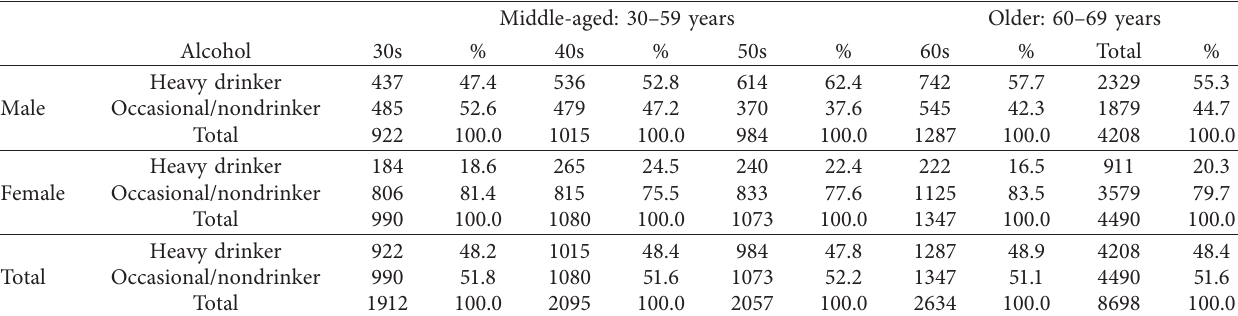
Table 2: Drinking trends of the study group according to age.